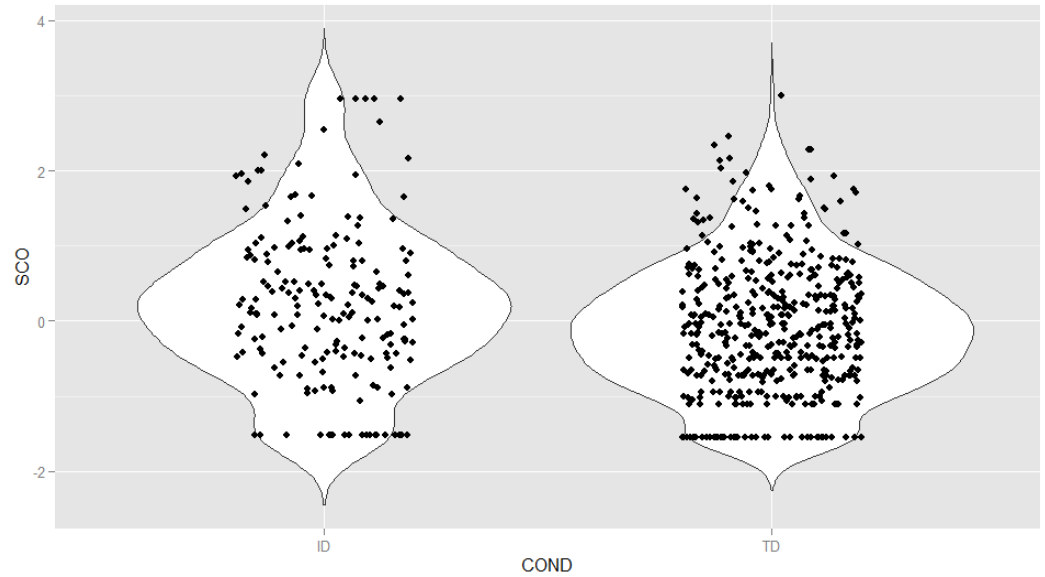
Figure 4. Distribution by group of the latent oppositional defiant disorder scores (M = 0, SD = 1). Note: TD = typical development; ID = intellectual disability group; SCO = standardized ODD latent scores; COND = condition.